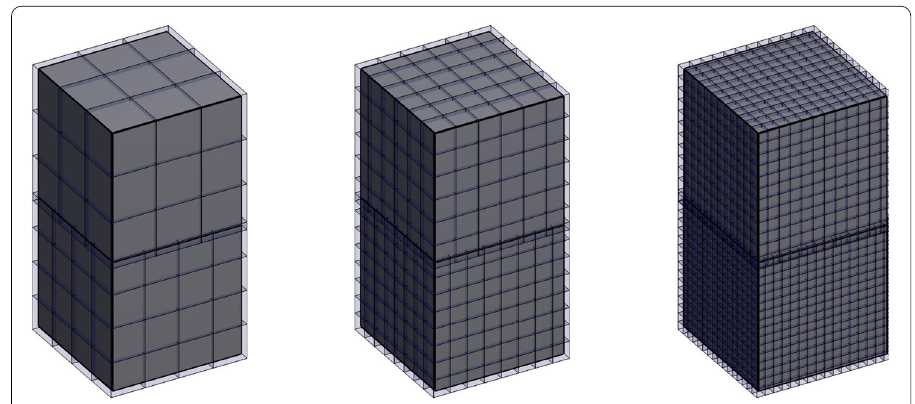
Fig. 8 Example 1. Refinement process for the study of the convergence of the solution. Meshes 1 to 3 are shown from left to right